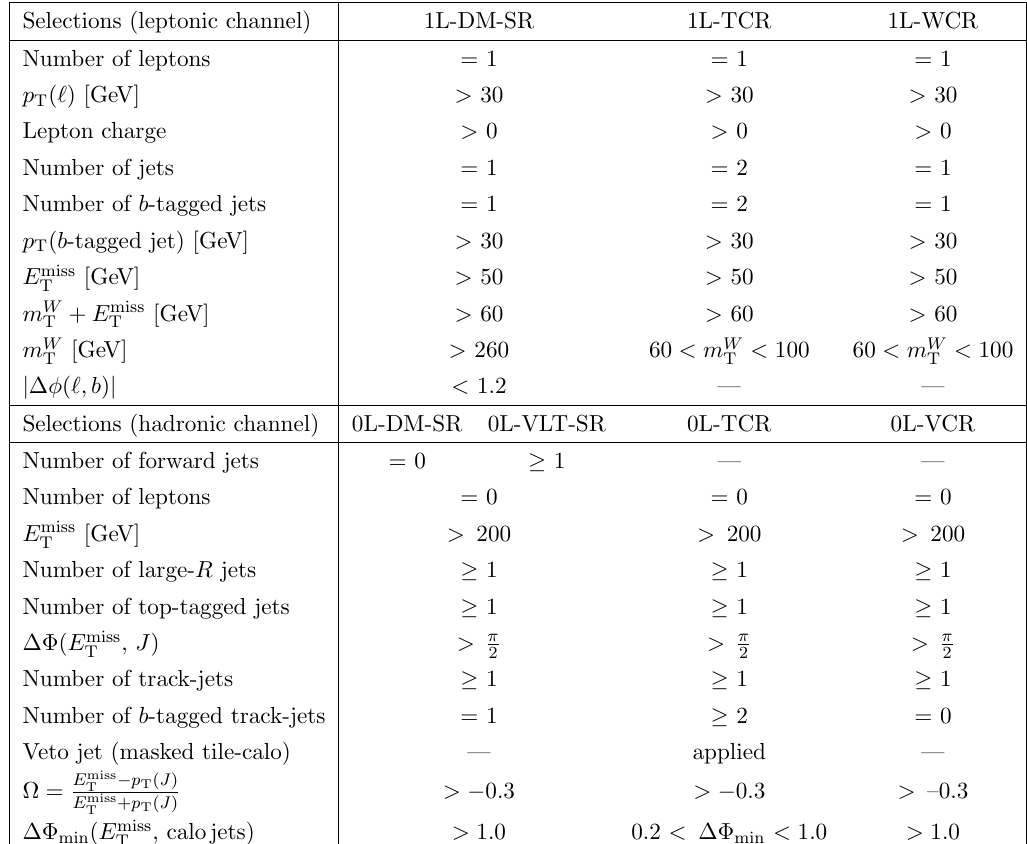
multijet background is estimated from the control region B, which di(cid:11)ers from the signal region by requiring zero top-tagged large- R jets. This shape is normalised by a factor which is calculated as the ratio of the numbers of multijet events in regions C and D. Region C (region D) di(cid:11)ers from the signal region (B region) by requiring (cid:1)(cid:8)( E miss